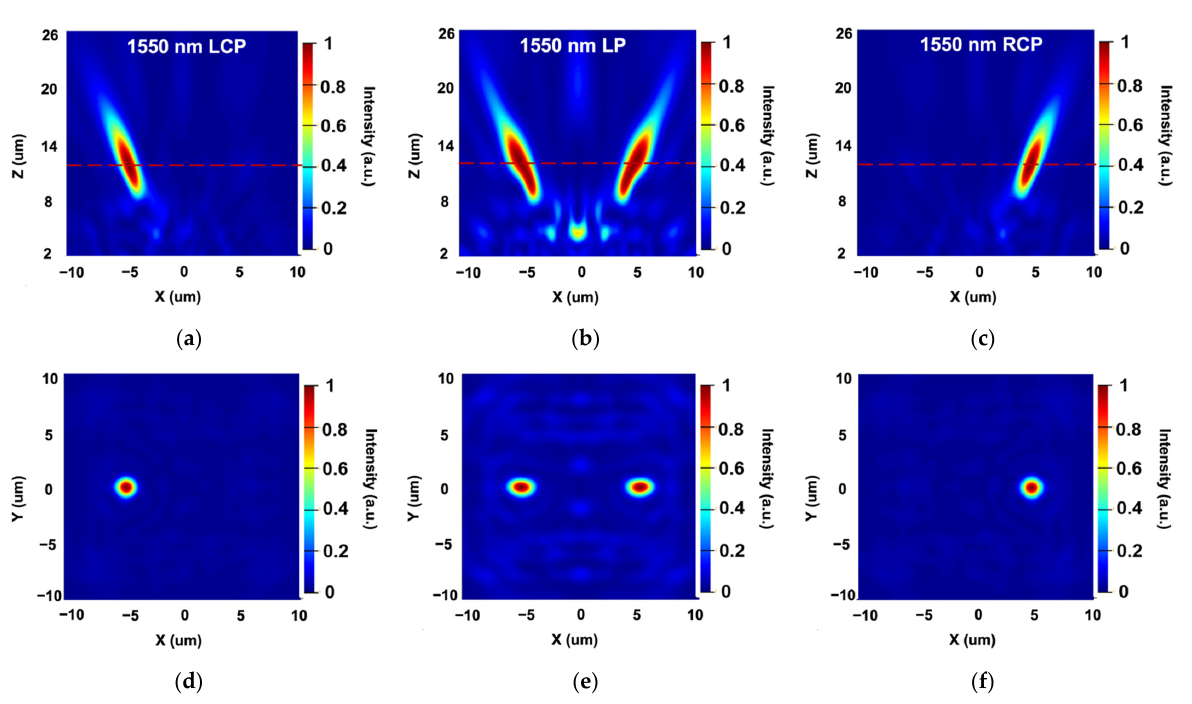
Figure 7. Performance of the dual-wavelength achromatic bifocal metalens at 1550 nm. ( a – c ) Simulated optical intensity of the proposed metalens with incident wavelength at the x–z plane when y equals 0 for LCP, LP and RCP. ( d – f ) Simulated optical intensity at the x–y plane at the designed focal plane.